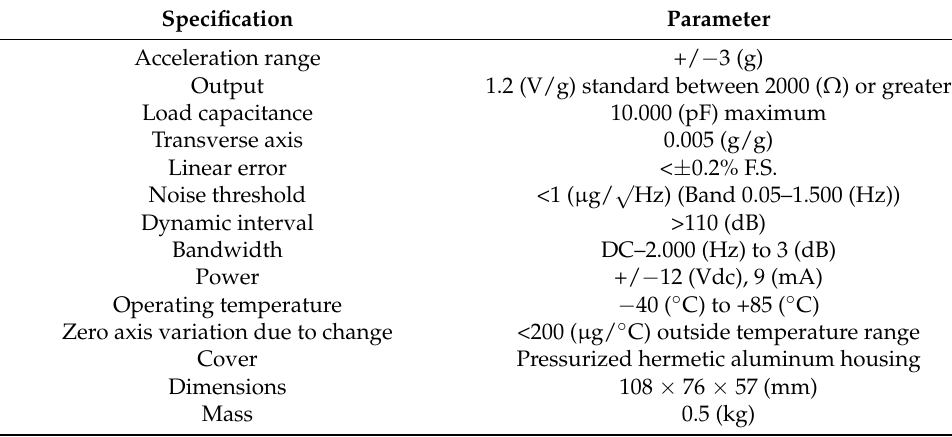
Figure 1. Northwest view ( left ) and typical plan view ( right ) of the building. Table 2. Specifications of the Digitexx uniaxial accelerometers.